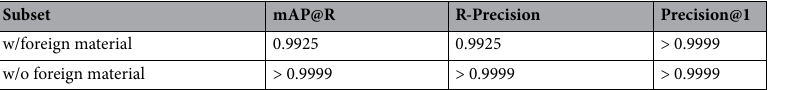
Table 4. Comparison of the re-identification performance on two different subsets (ChestX-ray14) that either contain foreign material or not. We report the mAP @ R , the R -Precision, and the Precision@1.